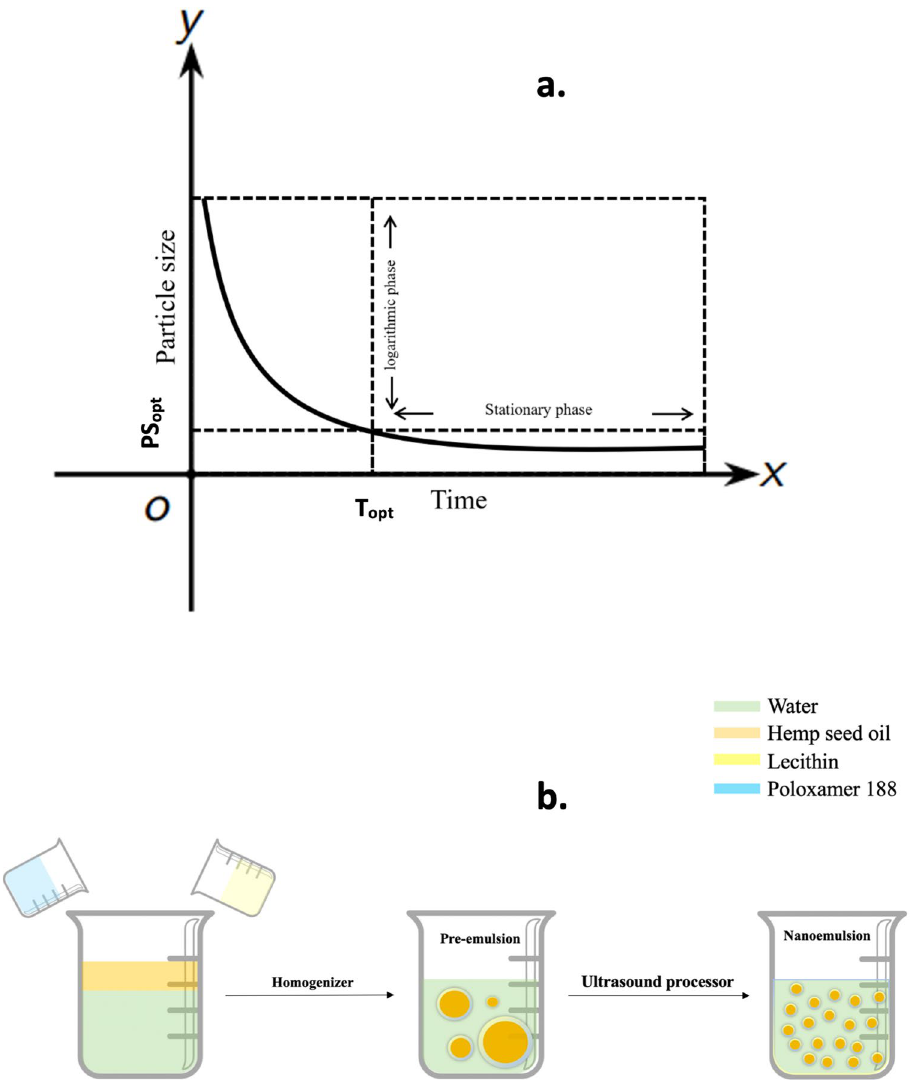
Figure 4. ( a ) Optimal nanoemulsion characterization, ( b ) Processing steps of the hemp seed oil nanoemulsion